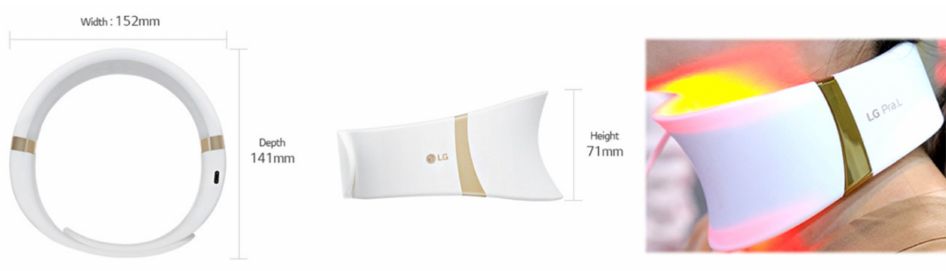
Figure 1. The home-use light-emitting diode (LED) neck device (SWL1, LG Electronics, Seoul,